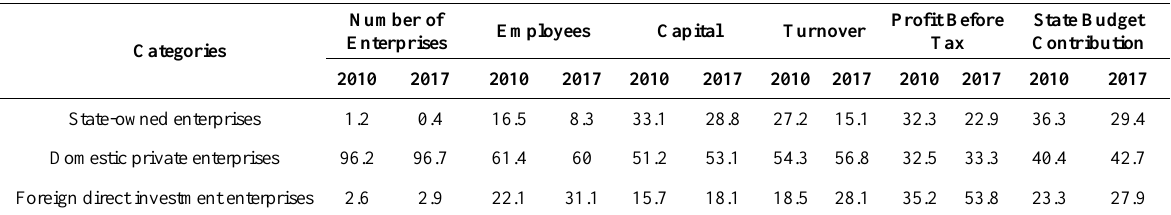
Table 1. Share of SOEs' Contribution in Comparison with Others (2010-2017)-Unit: Percentage (%)